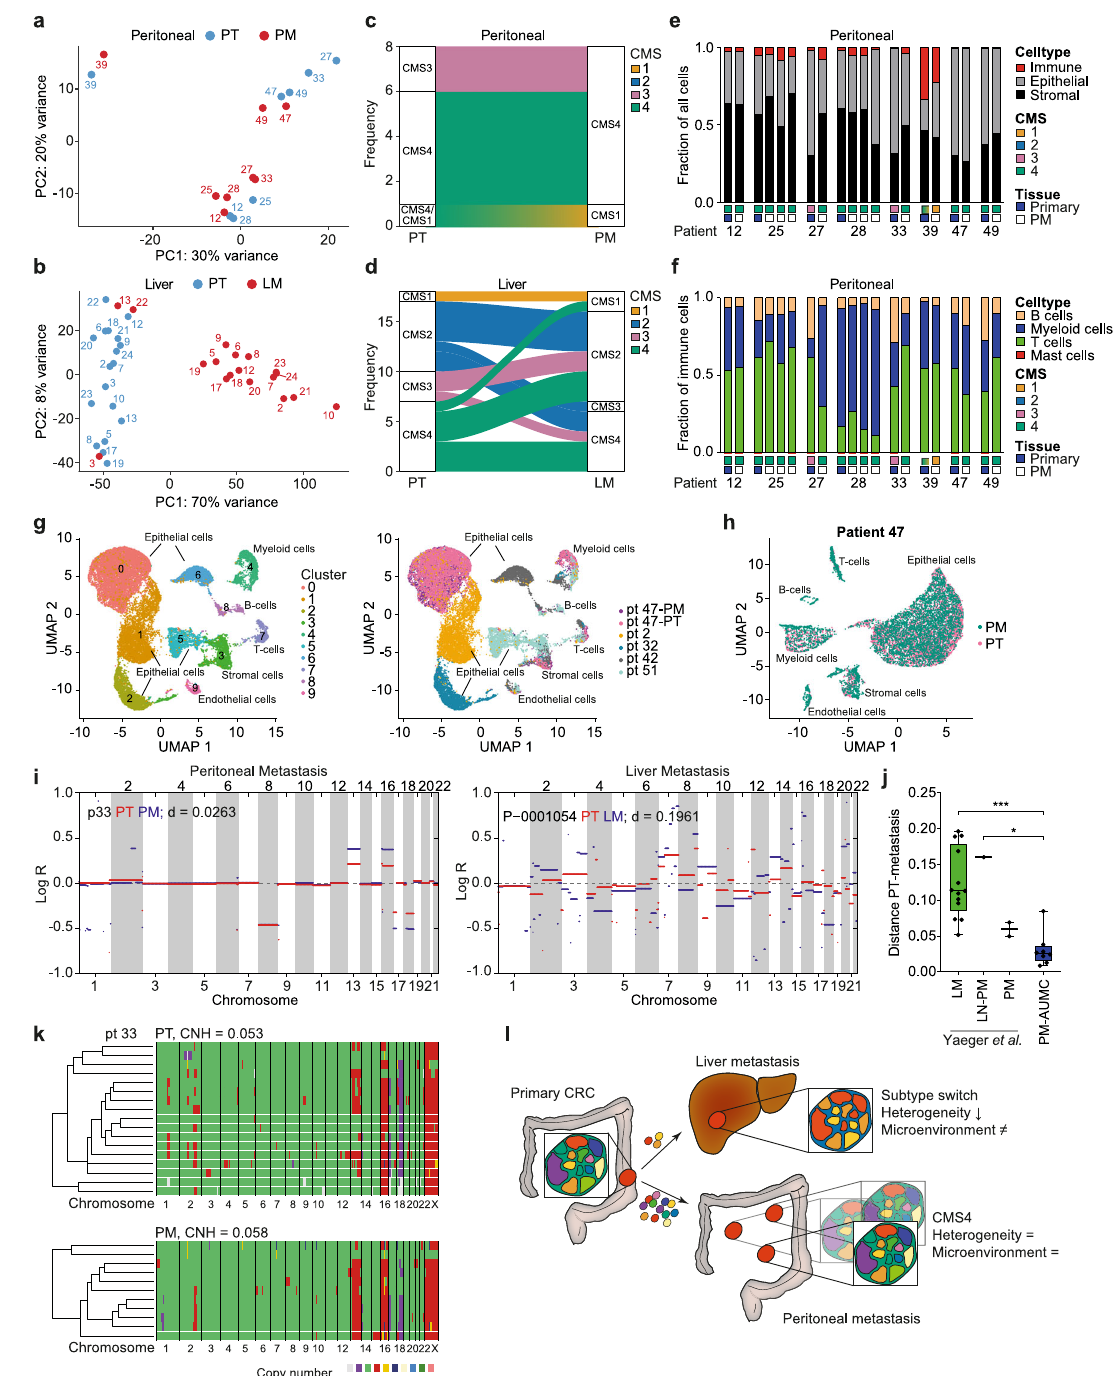
Fig. 4 | Primary tumor and peritoneal metastasis have highly similar pro fi les. a , b PCA plots of matching primary CRC (PT, blue) and peritoneal metastasis (PM, red, n =8 patients, a ), or liver metastasis (LM, red, n =18 patients, Kim et al. 69 , b ). Numbers correspond to patient ID. c , d Alluvial plot showing CMS classi fi cation of matching primary CRC (PT) and peritoneal metastasis samples (PM, n =8 patients, c )orlivermetastasis(LM, n =18patients, d ). e , f DeconvolutionofRNAsequencing data was used to compare total cellular composition ( e ) or immune cell composi- tion ( f ) of matched primary CRC (blue box) and PM (white box) samples, CMS of sample is indicated by colored boxes. g , h Single-cell transcriptome analysis was performed on 6 CRC samples (1 primary tumor, 5 PM samples). g UMAP (Uniform Manifold Approximation and Projection) plot of 26,570 cells from all 6 samples, color-coded by clusters (left panel) or sample ID (right panel). h UMAP plot of 11,689 cells from patient 47 (primary tumor (PT) and peritoneal metastasis (PM) sample), color-coded by sample type. i CNV pro fi les ofprimary CRC (PT,red lines)